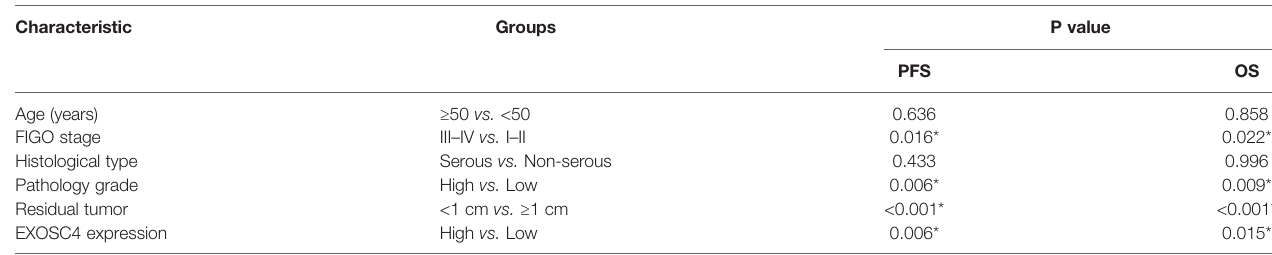
TABLE 3 | Univariate analysis to predict factors associated with PFS and OS.